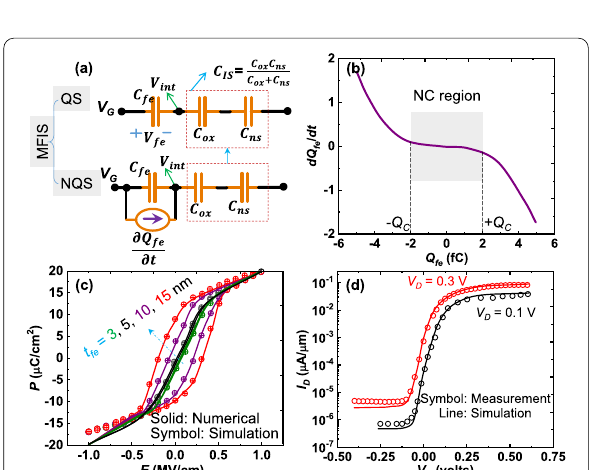
Fig. 1 a Capacitance equivalent circuit with QS (bottom) and NQS (top) structure of MFIS geometry. b Formulated d Q fe / d t with respect to Q fe . c Numerical (using L–K equation) and simulated (TCAD data) analyses of P – E relationship in the ferroelectric material at different ferroelectric thicknesses ( t fe ) [9, 12]. d Simulations are validated using the measurement data of a NC-TFET [6,